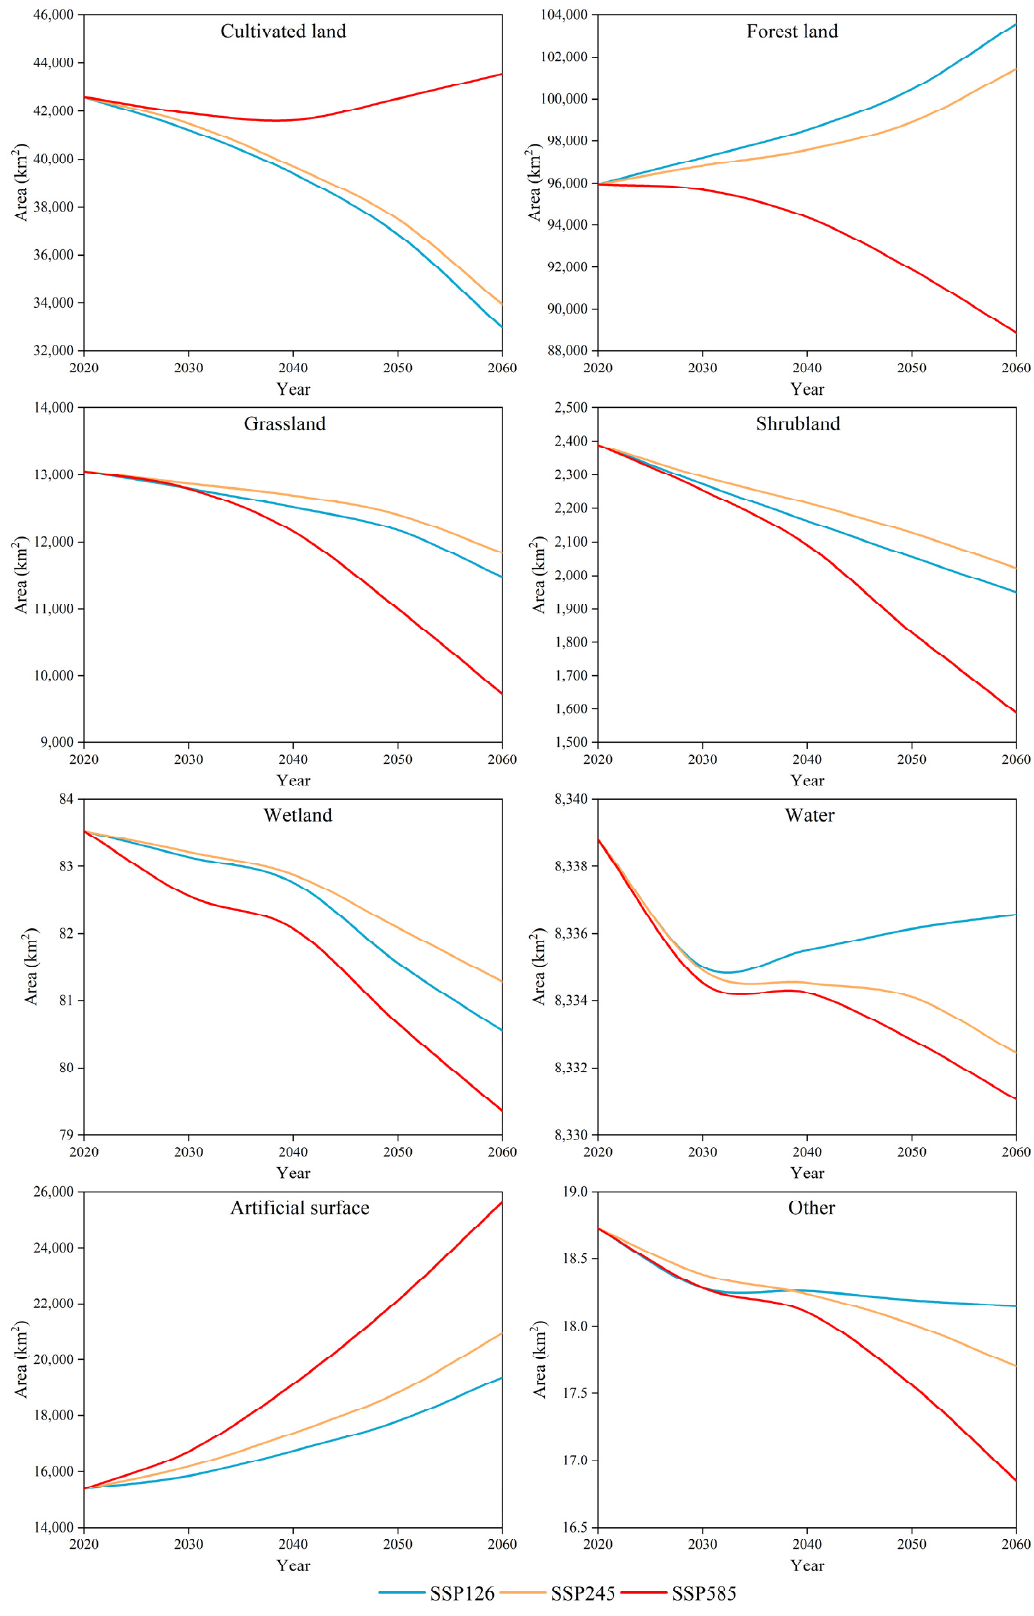
Figure 3. Demand prediction of each land use type under different